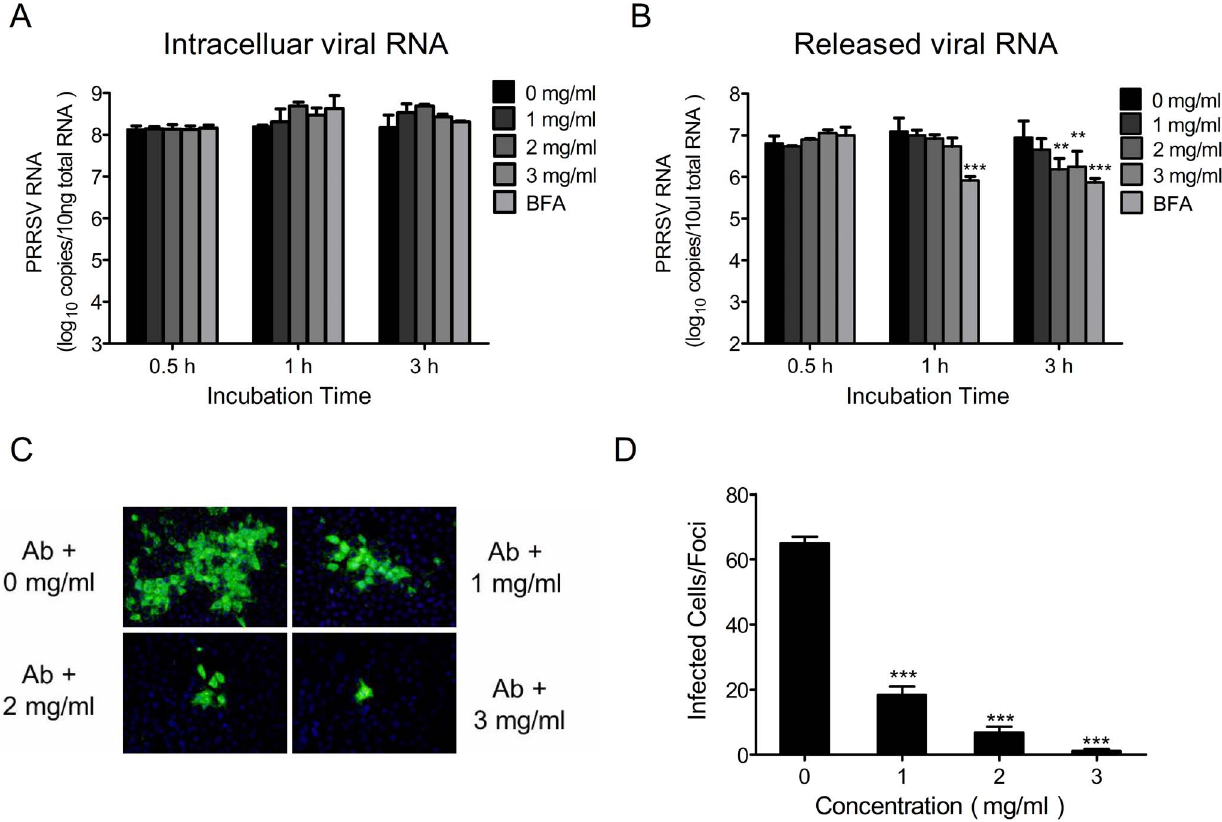
Figure 4. Cryptoporusvolvatus extract inhibits PRRSV release and cell-to-cell spreading. Determination of viral RNA released to the supernatants (A) or intracellular (B). Marc-145 cells were infected with PRRSV Ch1a (MOI of 0.1) for 24 h. After washing with PBS, cells were treated with either Cryptoporus volvatus extract or BFA (a known inhibitor of protein transport) for 0.5, 1, or 3 hours, and then copies of viral RNA in the supernatants and in the cells were determined using quantitative real-time RT-PCR assay. (C) PRRSV cell-to-cell spread is inhibited by Cryptoporus volvatus extract in a dose-dependent manner. Marc145-cells were incubated with CH-1a strain (MOI=0.01) for 3 h at 37 u C, and then culture medium was replaced with fresh medium containing Cryptoporus volvatus extract at indicated concentrations and neutralizing antibody (10% vol/vol). PRRSV N protein expression in cells was observed using indirect immunofluorescence at 24 hours after infection. Micrographs chosen to illustrate the sizes of infected cell foci (N expression, green). (D) Average number of infected cells per foci. Data are representative of three independent experiments (mean 6 SD). Statistical significance was analyzed by Student’s t test ; * P , 0.05 ; ** P , 0.01 ; *** P , 0.001 .